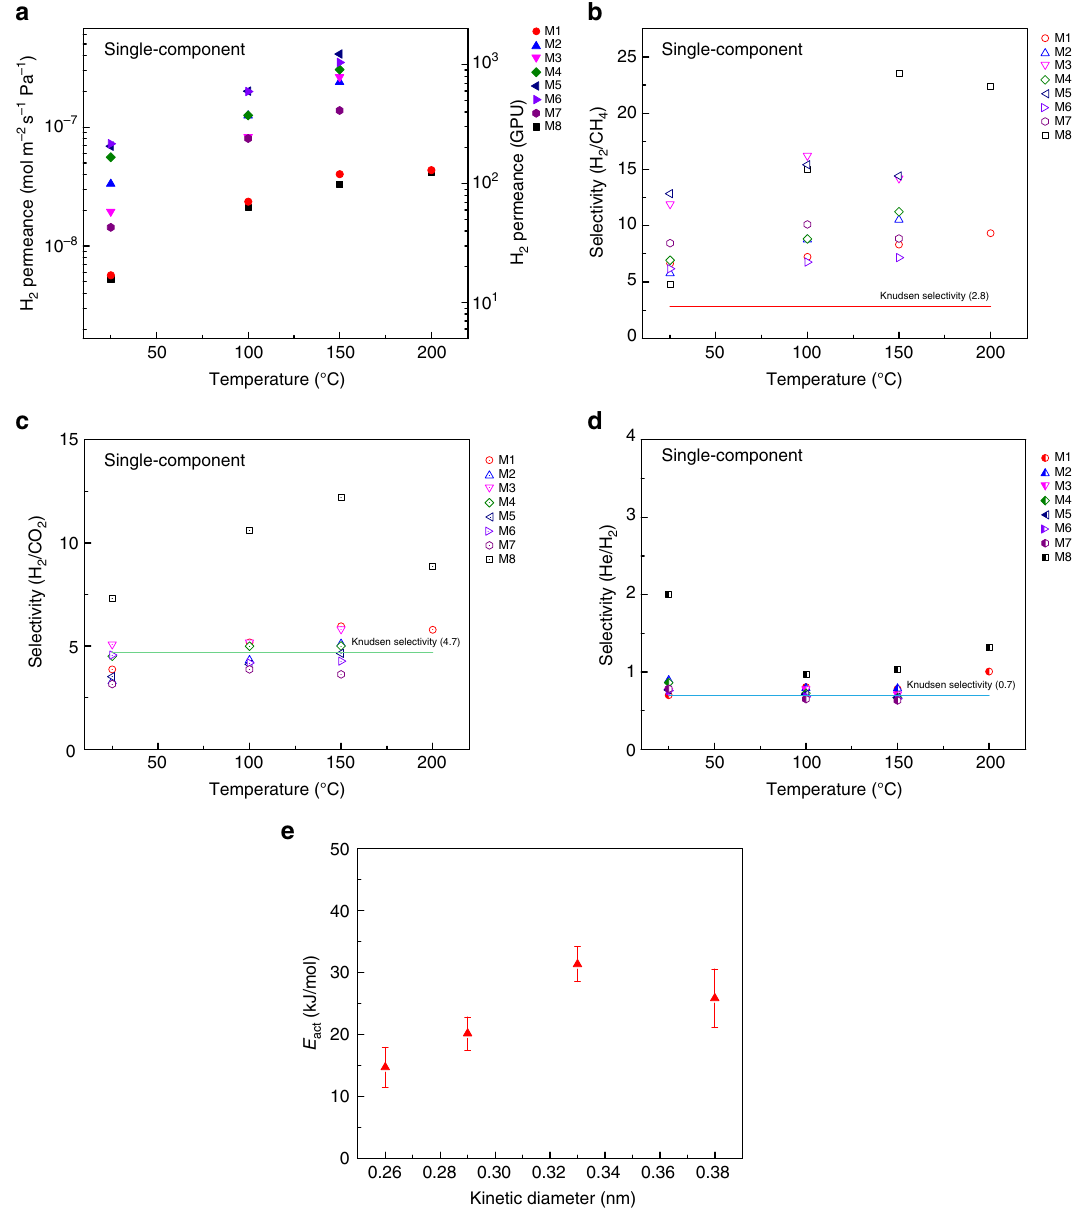
Fig. 3 Gas separation performance of the intrinsic defects in graphene. a H 2 permeance across eight graphene membranes (M1 – M8) as a function of temperature when using a single-component feed. b – d Ideal selectivities for various gas pairs from the eight membranes as a function of temperature; b H 2 /CH 4 , c H 2 /CO 2 , and ( d ) He/H 2 . e Extracted activation energies (average across all eight membranes) are plotted as a function of the kinetic